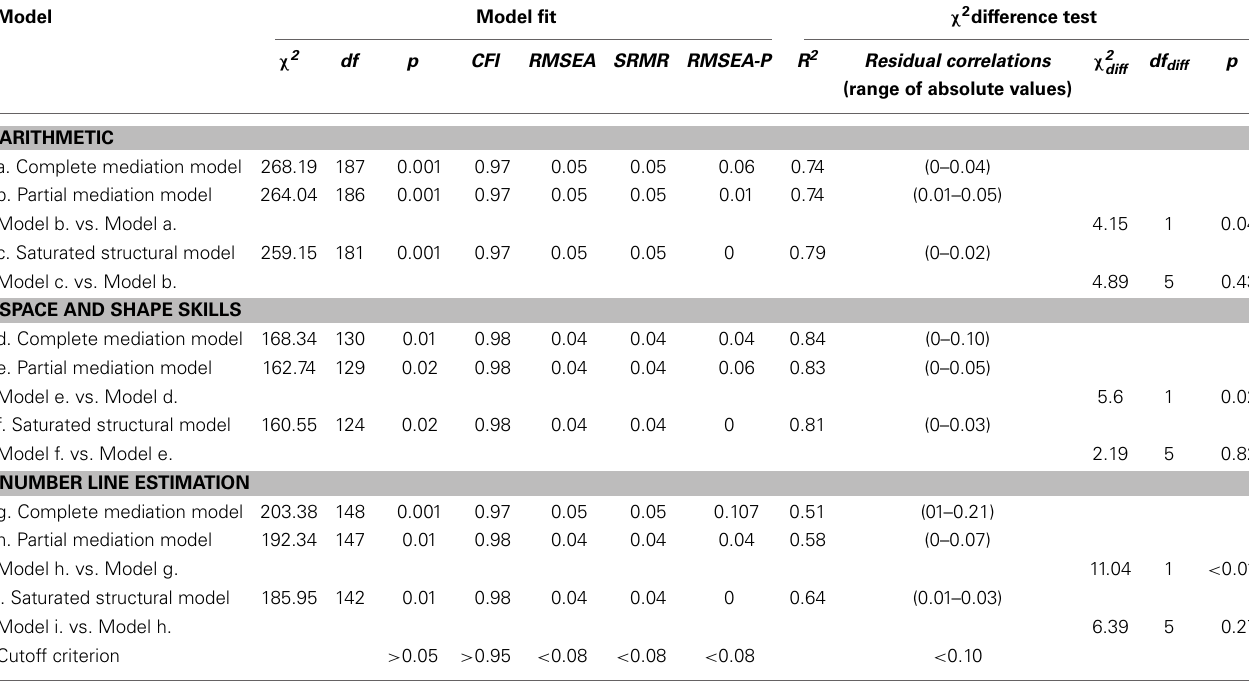
Table 4 | Mediation models to study how kindergarteners’ abilities affect math outcomes in first grade via early number competence: fit statistics, parameters and chi-square difference